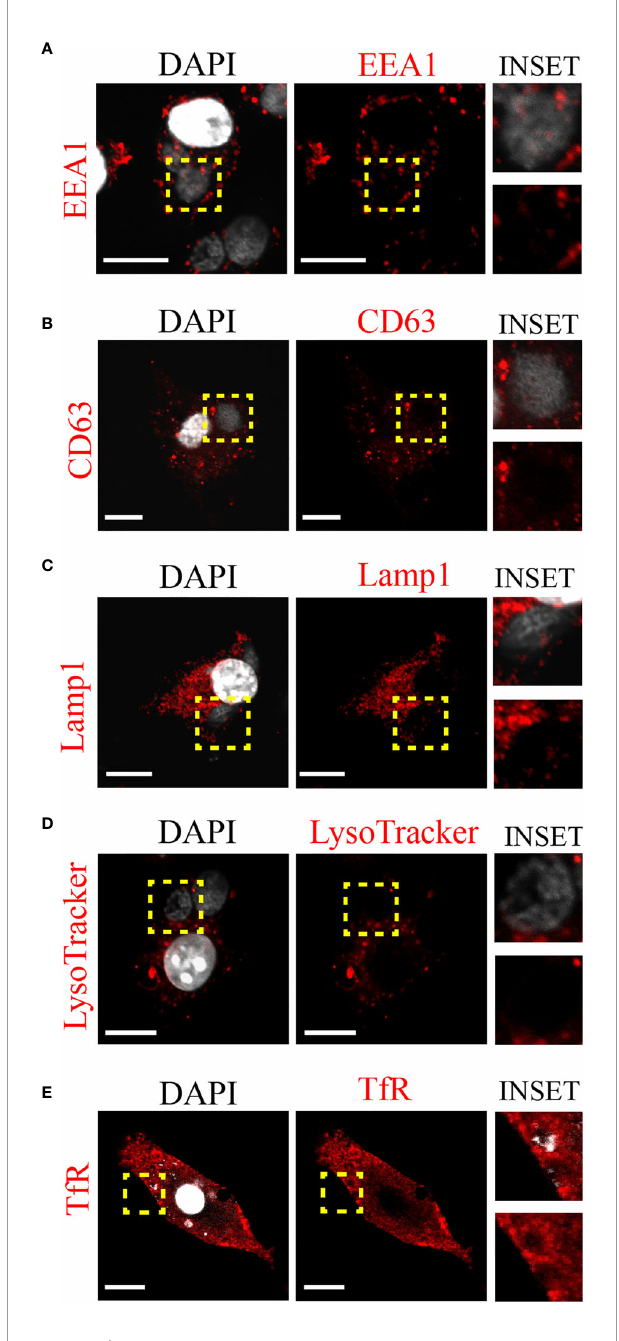
FIGURE 2 | C. trachomatis interacts with recycling endosomes in JAWS-II DCs. JAWS-II DCs were infected with C. trachomatis L2 (MOI 100) for 24 h and evaluated by confocal microscopy. The intracellular distribution of (A) early endosomes (EEA1), (B) late endosomes (CD63), (C) lysosomes (Lamp1), (D) acidic compartments (LysoTracker), and (E) recycling endosomes (TfR) were analyzed. Insets show a magni fi cation of the chlamydial inclusion. For each marker, staining with the primary antibody was followed by its corresponding Cy3-conjugated secondary antibody. DAPI was used to stain DNA. Bars represent 10 um. Images are representative of three independent experiments and more than 20 images were analyzed for each endosomal